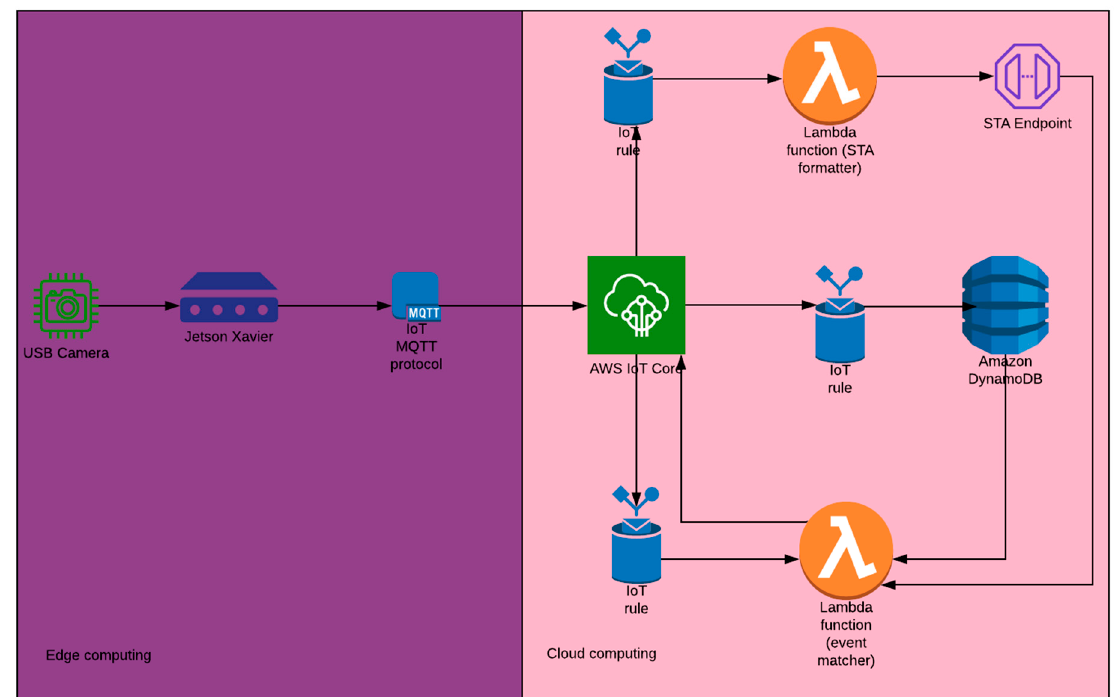
Figure 3. Implementation diagram of the developed architecture (IoT: internet of things, STA: SensorThing API, MQTT: message queuing telemetry transport, AWS: Amazon web services).